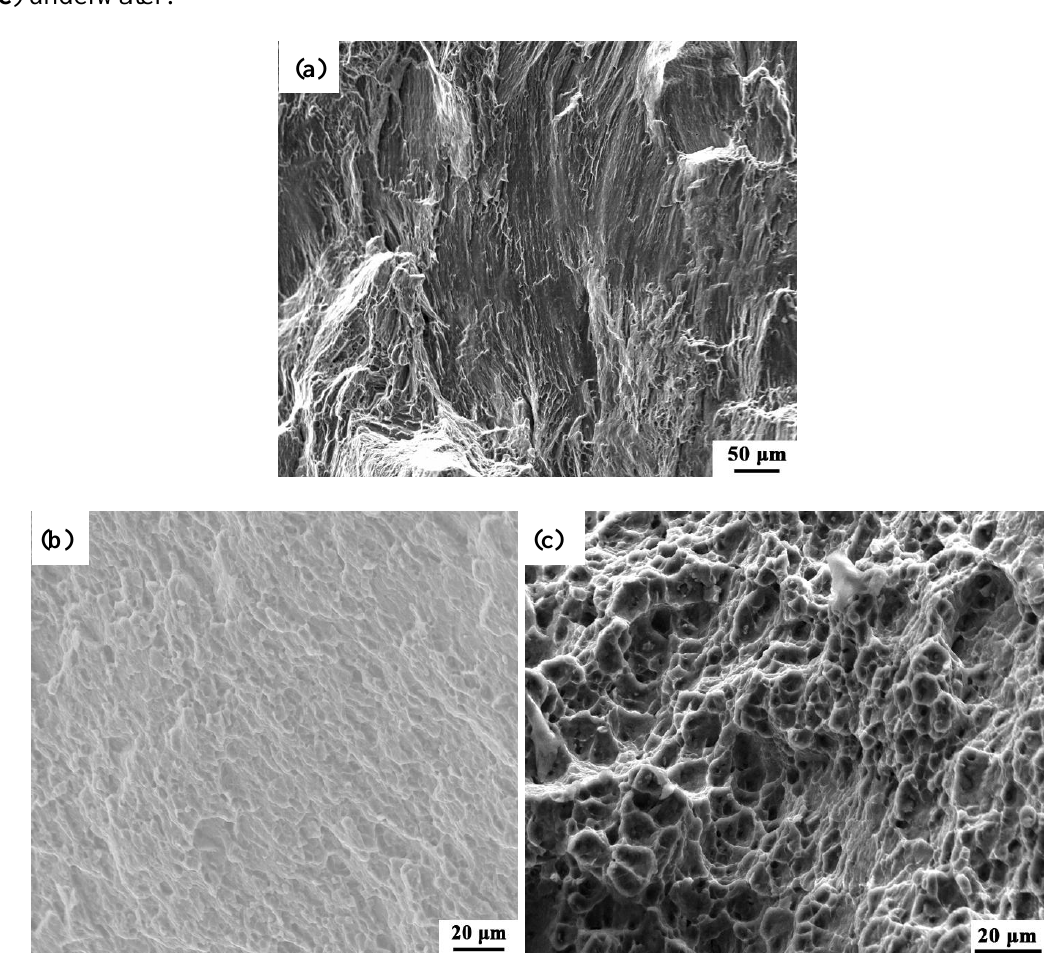
Figure 9. Fracture surfaces of AZ31 alloys at room temperature: ( a ) BM; ( b ) in air; ( c )